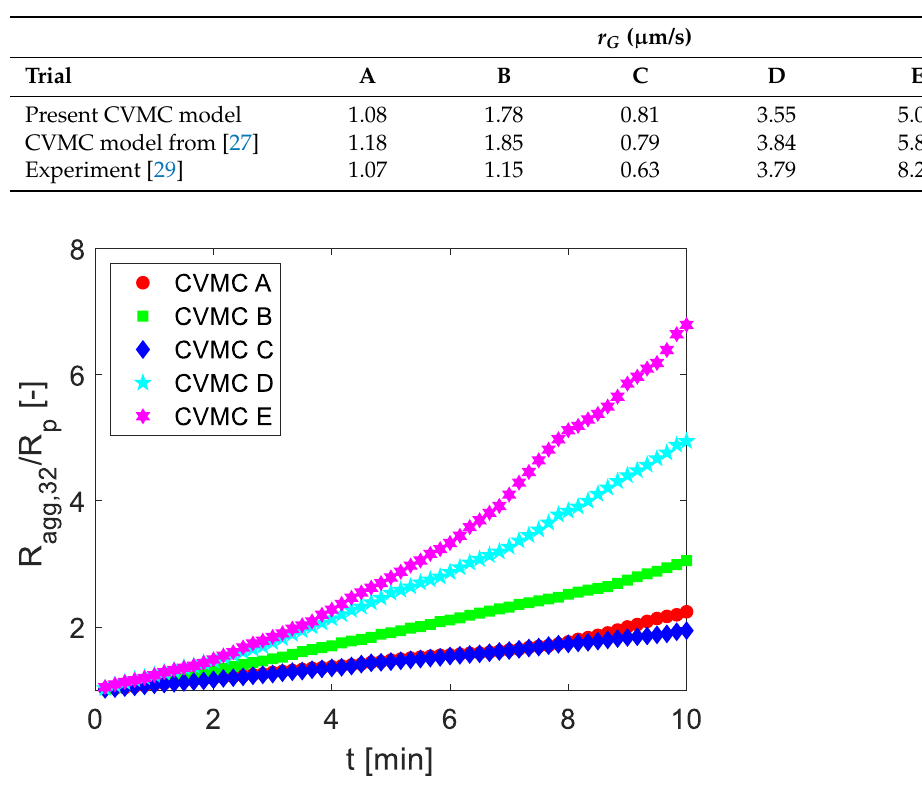
Figure 8. Temporal growth of particles by employing the CVMC simulation for the different experiments.